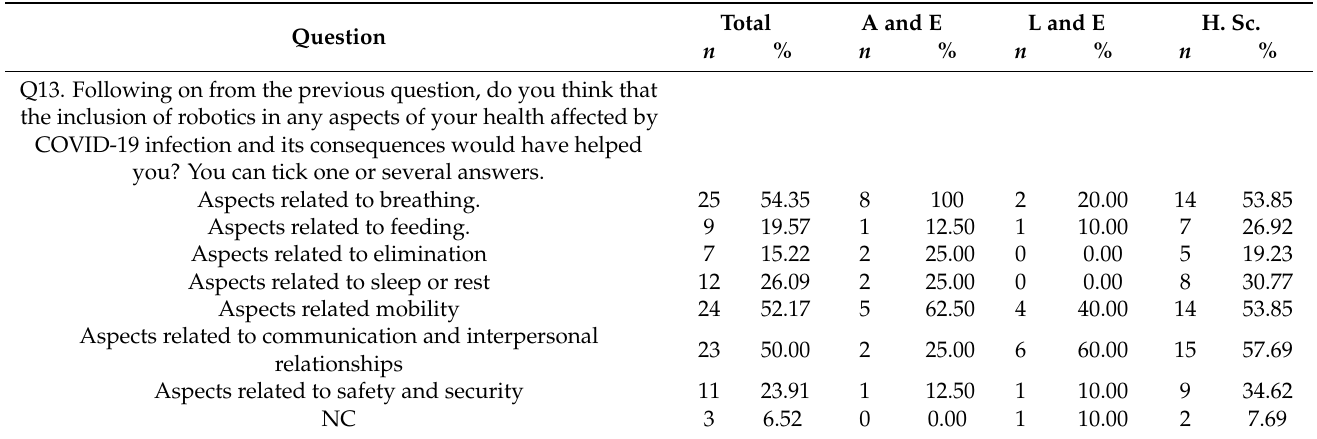
Table 11. Distribution of answers on the help of robotics in health